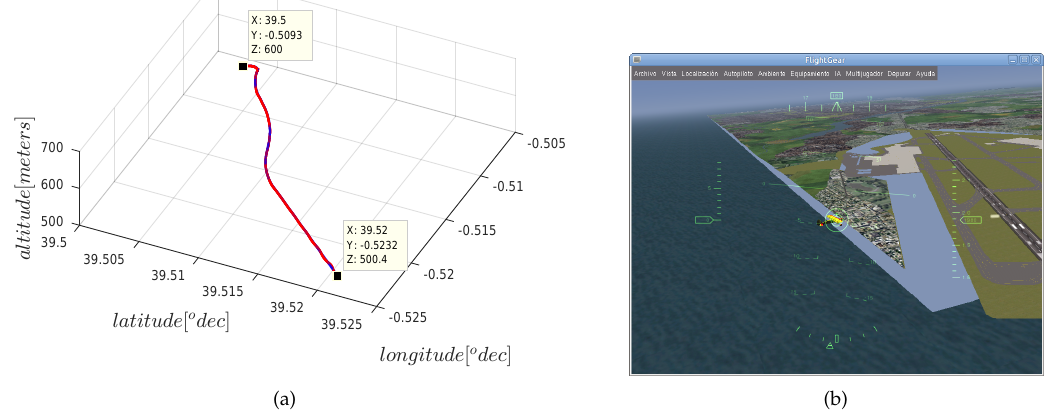
Figure 10. Simulation of the UAV flight simulink, where the starting point is [ 39.52, − 0.5232,500 ] and the target point is [ 39.50, − 0.5093,600 ] . ( a ) Flight of the UAV, where the blue line is the path calculated from the process described and the red line is the actual path of the UAV. ( b ) View from a model